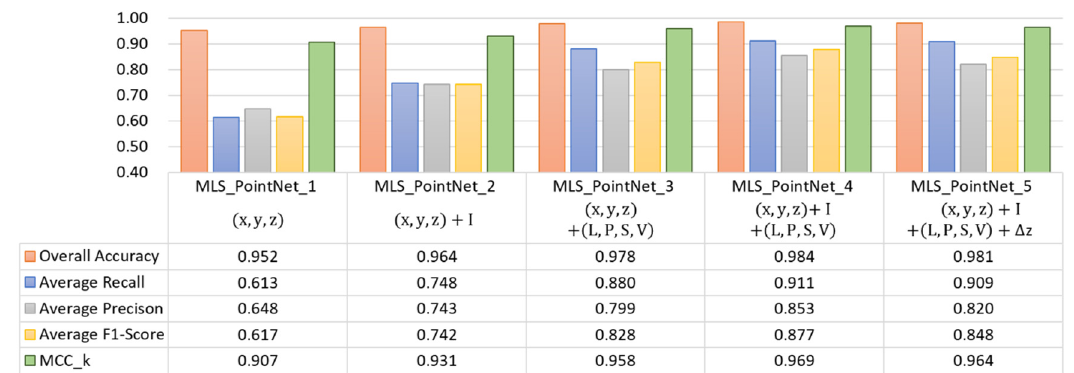
Figure 11. Comparison of classification results using PointNet with different handcrafted features on MLS point clouds.